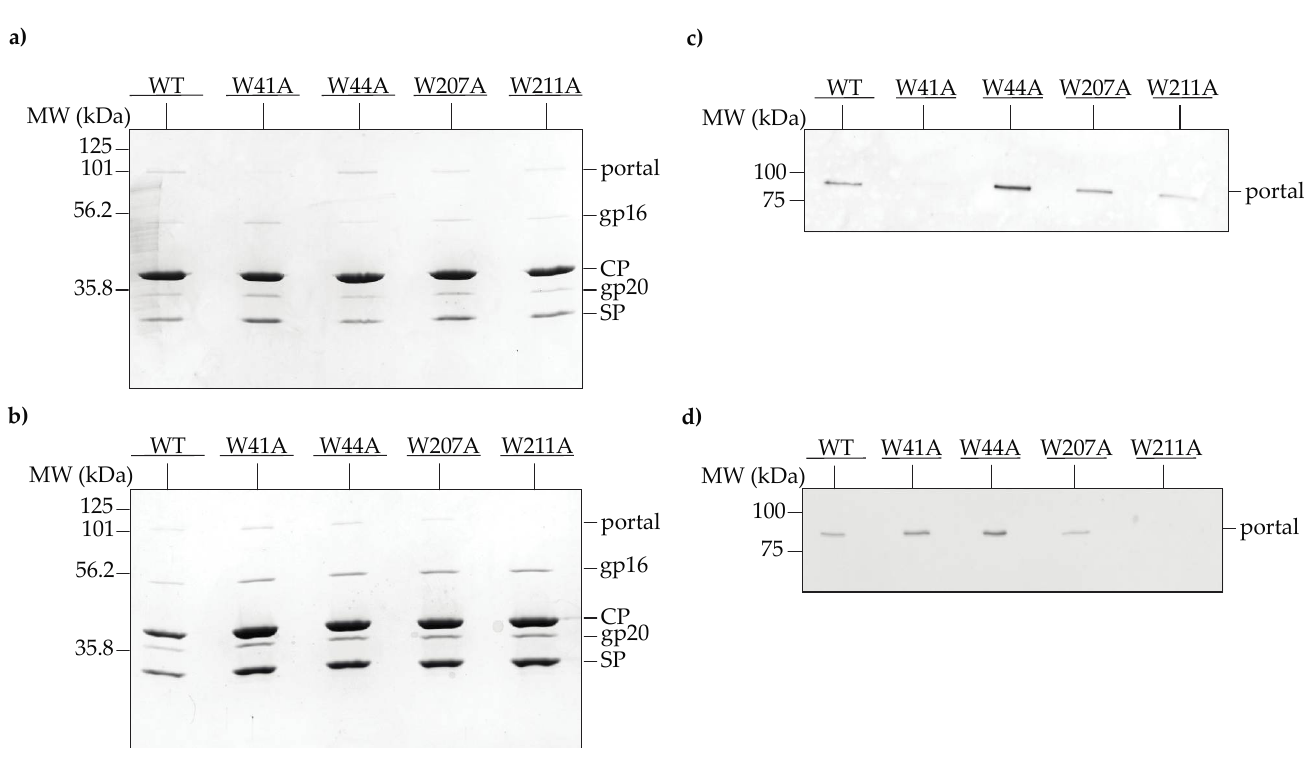
Figure 3. In vivo incorporation of WT and mutant portal protein into PCs at 30 ◦ C (top row) and 37 ◦ C (bottom row). ( a , b ) Cells carrying plasmids that express WT and variant portal genes upon induction with anhydrotetracycline were infected with gene 1 amber phage, then separated in 5–20% sucrose gradients and analyzed by 10% SDS-PAGE. The peak PC-containing fractions are shown above. Positions of portal protein, coat protein (CP), scaffolding protein (SP) and the ejection proteins, gp16 and gp20, are indicated on the right; ( c , d ) fluorescent Western blot of the corresponding sucrose gradient fractions using StrepMAB-Classic antibody.